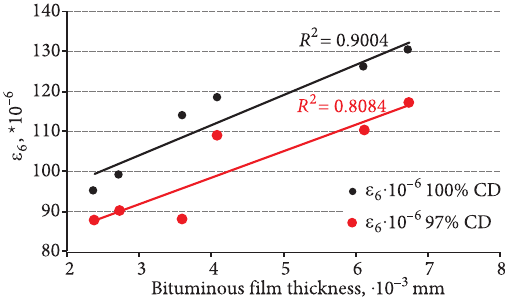
Fig. 7. Relationship between the fatigue characteristic ε 6 and the bitumen film thickness on the surface of the AC 16 mixture aggregate (CD – compaction degree) Table 6. Low temperature properties of AC 11 type mixtures